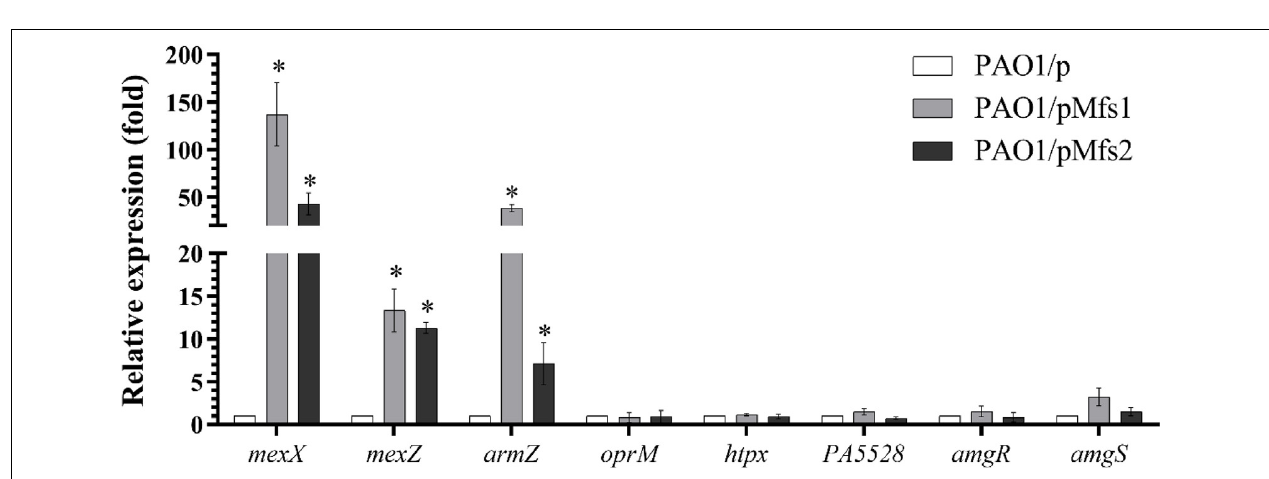
FIGURE 4 | Expression analysis of mexX and genes involved in mexXY regulation in PAO1/pMfs1 and PAO1/pMfs2 using semi-quantitative RT-PCR compared to PAO1/p. Data shown are mean ± SD and asterisk ( ∗ ) indicates significant difference relative to PAO1/p ( p- value <